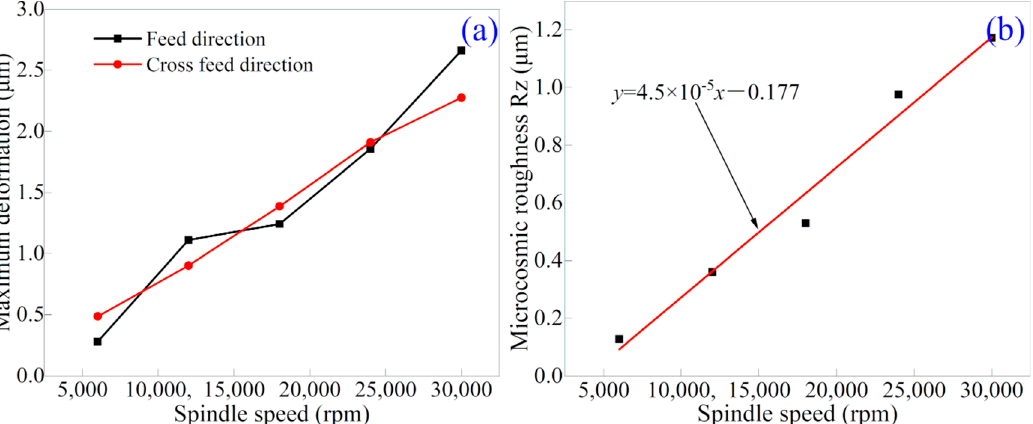
11 of 12 Figure 9. FE simulation results of machined surface morphologies under different spindle speeds: ( a ) 6000 rpm, ( b ) 18,000 rpm, ( c ) 24,000 rpm and ( d ) 30,000 rpm. Figure 10a,b present the simulated results of the maximum deformation of the mill- ing tool and the microscopic roughness Rz of the machined surface for spindle speeds ranging from 6000 rpm to 30,000 rpm, respectively. Figure 10a shows that, with the in- crease in spindle speed, the maximum deformations of the milling tool in both the feed